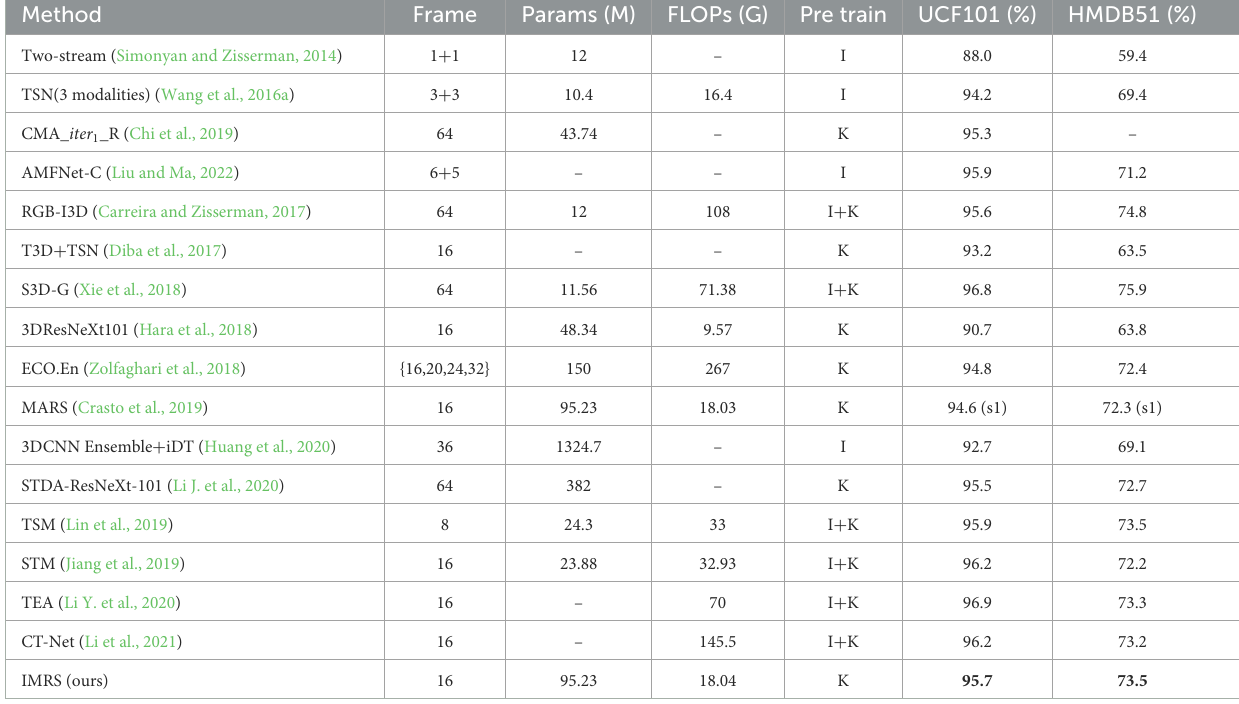
TABLE 5 Compared with the mainstream